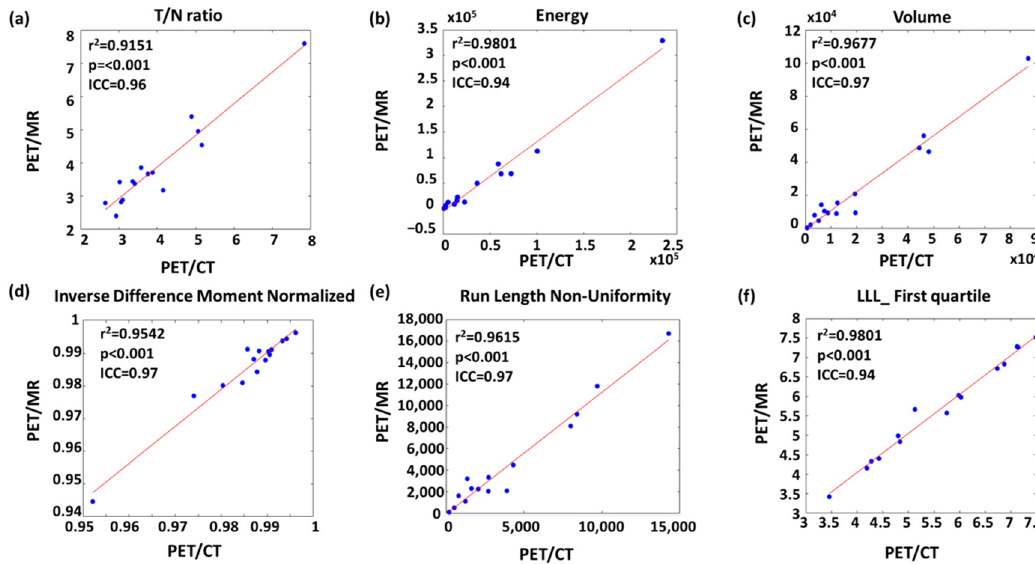
Figure 5. Linear regression of representative ( a ) conventional, ( b ) histogram, ( c ) geometric, ( d ) GLCM-texture, ( e ) GLRLM- texture and ( f ) wavelet features with strong comparability between PET/CT and PET/MR.